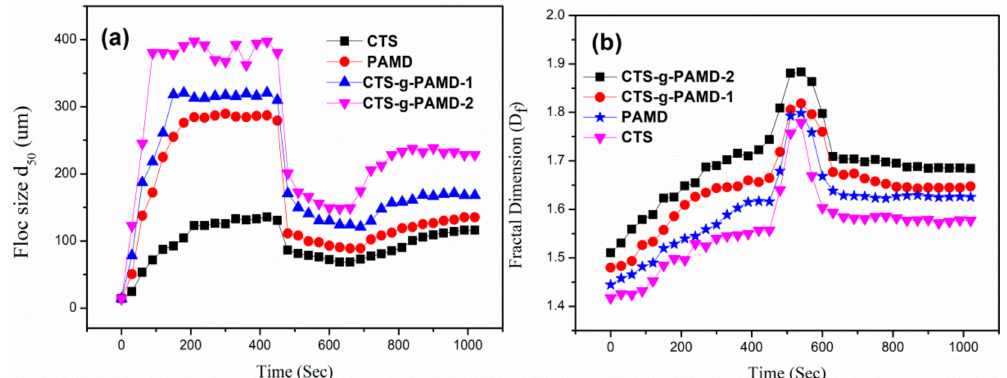
Figure 11. Floc formation, breakage and regrowth process at 400 r / min: evolution of ( a ) floc size and ( b ) fractal dimension over